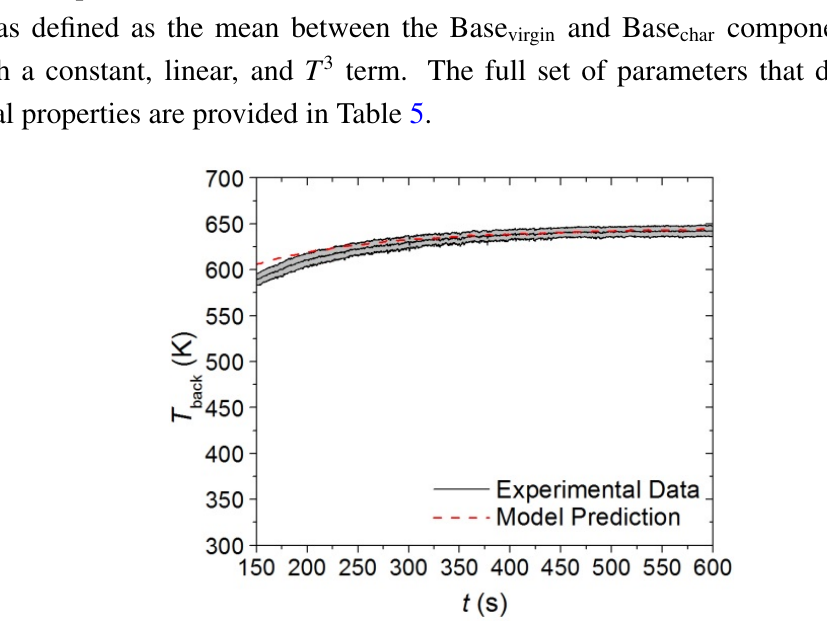
Figure 14. Final 450 s of experimental T back curve measured in CAPA tests and corresponding model predicted curve for the base layer exposed to a radiant flux of 30 kW·m − 2 . The shaded region corresponds to two standard deviations of the mean experimental data.